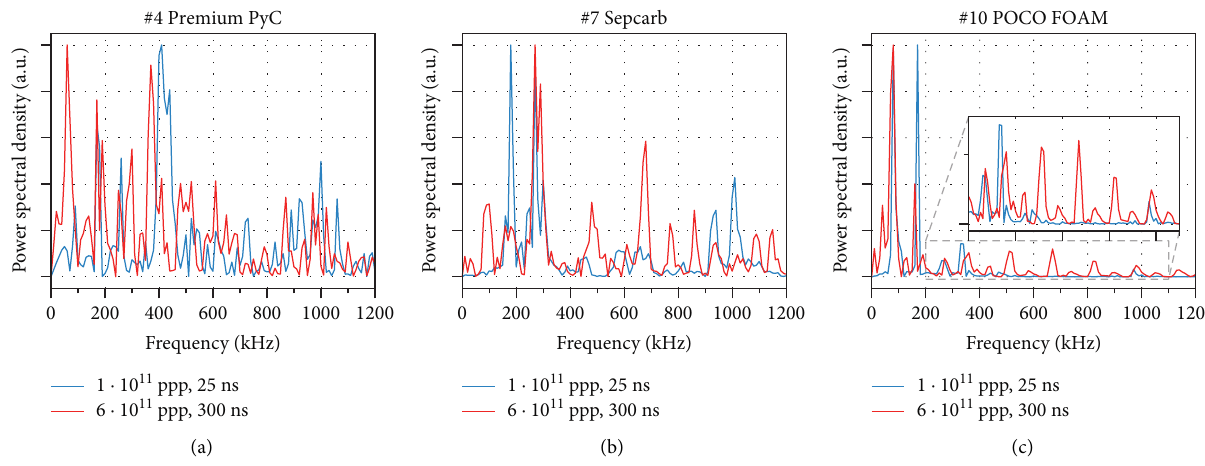
Figure 15: Frequency analysis of the radial surface velocity presented in Figure 14. The normalized power density within the first 100 μ s after beam impact is shown for beam impacts with intensities of 1 × 10 11 and 6 × 10 11 ppp of samples #4 Premium PyC (a), #7 Sepcarb (b), and #10 POCO FOAM (c). The inset in (c) shows the zoomed region in which the split radial signal is expected.